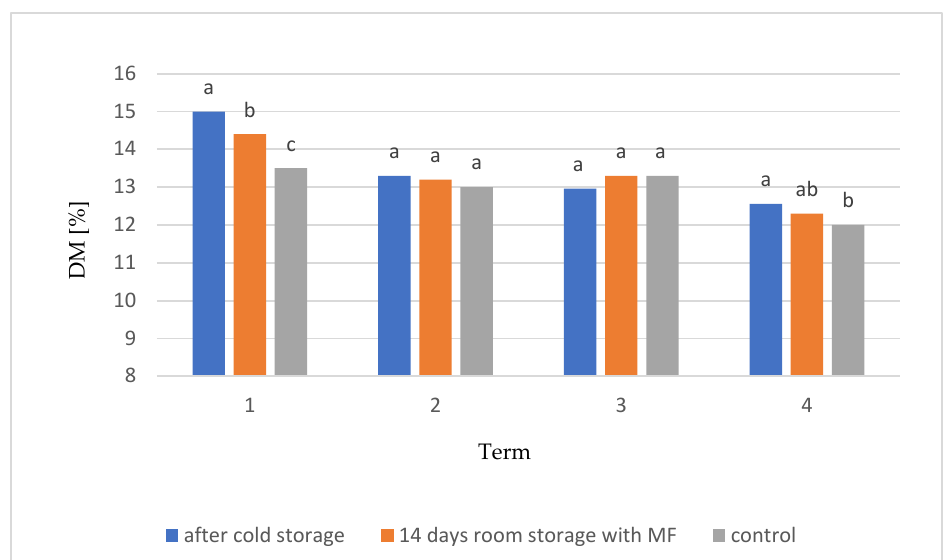
Figure 9. Effects of MF on the DM of Idared apples after 120 days of cold storage. For each experiment, apples were stored in room conditions for 14 days. Statistically significant differences are marked by different letters. Differences between average values that are marked with the same letters (a – b) are not statistically significant. The data were analysed separately for each experiment.